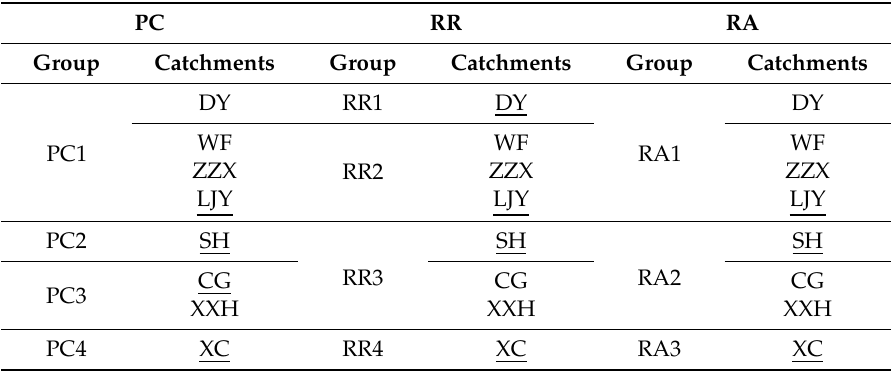
Table 4. The groups from cluster analysis of the eight